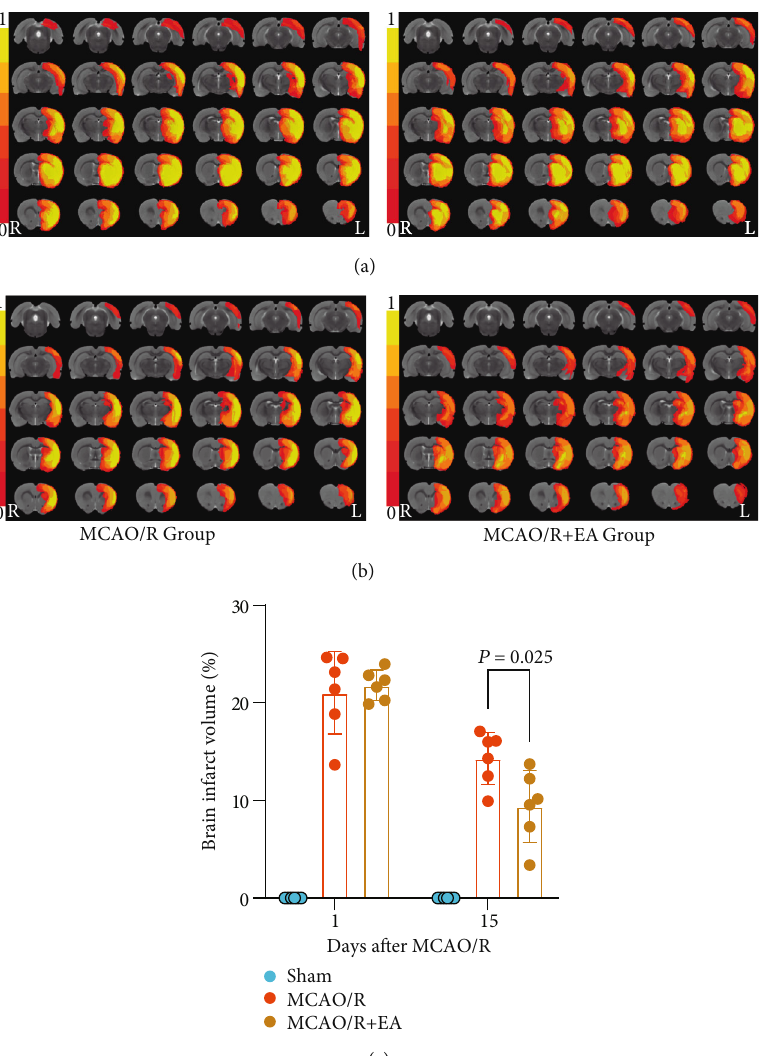
Figure 4: T2-weighted imaging signal changes before and after EA treatment. Changes in the infarct region and damaged volume were measured by T2-weighted imaging in the MCAO/R and MCAO/R+EA groups before (a) and after (b). Changes in the infarct region and damaged volume are represented as a percentage of the total brain volume. All data are presented as the mean ± standard deviation , n = 6 . Abbreviations: EA: electroacupuncture; MCAO/R: middle cerebral artery occlusion-reperfusion; L: left; R: